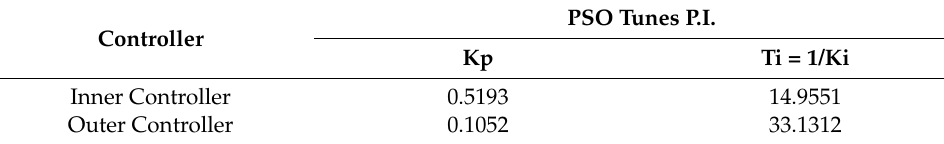
Table 4. Classical parameters .